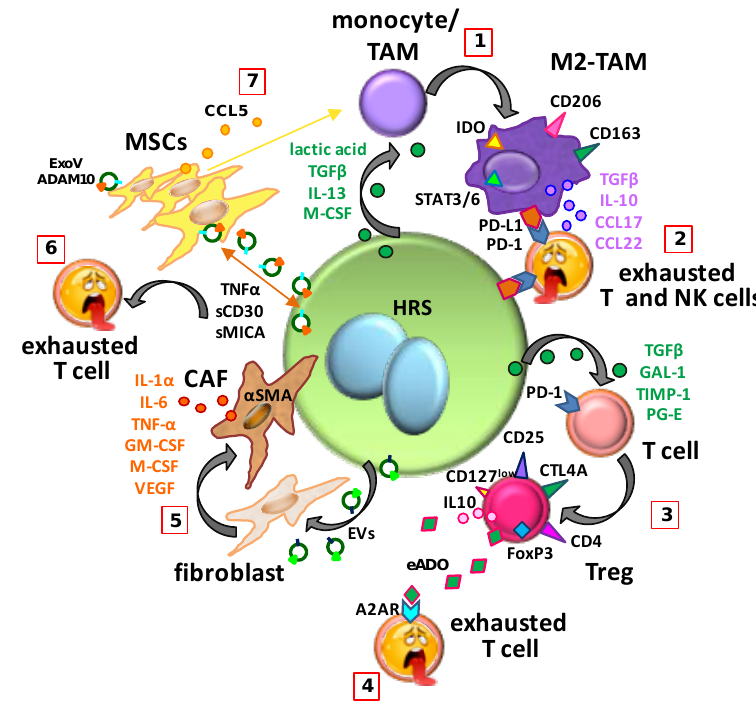
Figure 1. Education of normal cells in the tumor microenvironment of classic Hodgkin lymphoma. ( 1 ) Hodgkin and Reed–Sternberg (HRS) cells, by secreting transforming growth factor β (TGF- β ), interleukin (IL)-13, macrophage colony-stimulating factor (M-CSF) and lactic acid, educate monocytes or tumor-associated macrophages (TAMs) to become immunosuppressive M2-TAMs (programmed death-ligand 1, PD-L1 + ; and indoleamine 2,3-dioxygenase, IDO + ). ( 2 ) M2-TAMs, by secreting TGF- β , IL-10, C-C motif chemokine ligand (CCL) 17 and CCL22 and by expressing PD-L1 and IDO, induce exhaustionofprogrammedcelldeathprotein1(PD-1) + e ff ectorTandNKcells. ( 3 )HRScells, bysecreting TGF- β , galectin-1 (GAL-1), tissue inhibitor of metalloproteinase-1 (TIMP-1) and prostaglandin (PG-E), induce the di ff erentiation of CD4 + T cells towards regulatory T cells (Tregs) (forkhead box P3, FoxP3 + ). ( 4 ) High levels of extracellular adenosine (eADO) in the TME inhibit T e ff ector cell activity. ( 5 ) Extracellular vesicles (EVs) secreted by HRS cells convert fibroblasts to α smooth muscle actin ( α SMA) + cancer-associated fibroblasts (CAFs) that secrete IL-1 α , IL-6, tumor necrosis factor (TNF- α ), M-CSF, granulocyte-macrophage colony-stimulating factor (GM-CSF), and vascular endothelial growth factor (VEGF). ( 6 ) The mature, bioactive form of A Disintegrin And Metalloproteinase (ADAM10) is released in exosome-like vesicles (ExoV) by HRS cells and lymph node mesenchymal stromal cells (MSCs). Di ff usion of ADAM10 activity due to ExoV results in the release of TNF- α , MHC class I chain-related a (sMICA), and soluble sCD30 that may interfere with host immune surveillance, immunotherapy or brentuximab vedotin activity. (7) HRS cells induce MSC growth and educate MSCs to secrete CCL5. Tumor-educated MSCs (E-MSCs), through the secretion of CCL5, recruit monocytes. CTLA4, cytotoxic T lymphocyte antigen 4; STAT3 / 6, signal transducer and activator of